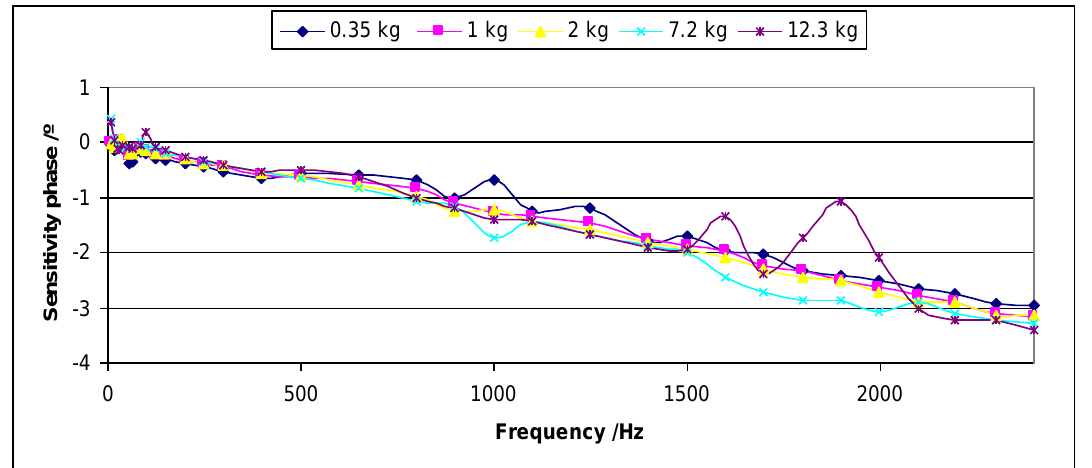
Figure 13. Each curve represents the sensitivity phase for each load versus frequency for the Interface 1610